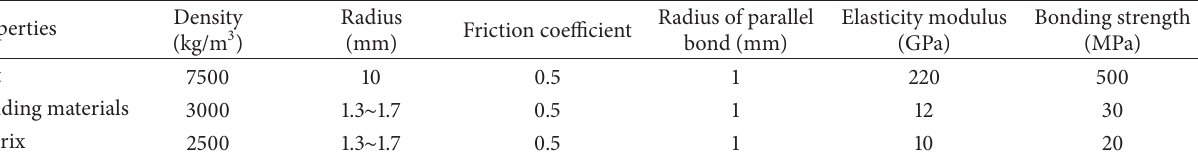
Table 1: Micromechanical parameters of anchorage body’s pull-out test.